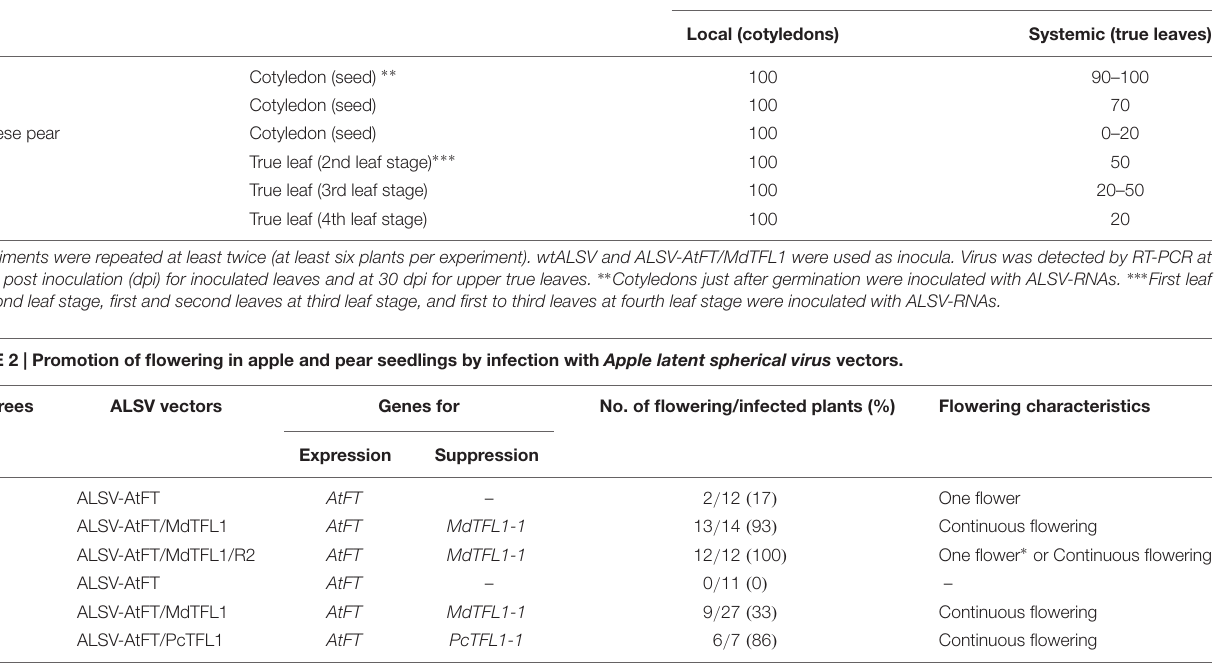
TABLE 1 | Infection rate of apple latent spherical virus (ALSV) vectors to apple, pear, and Japanese pear following biolistic inoculation ∗ . Plants